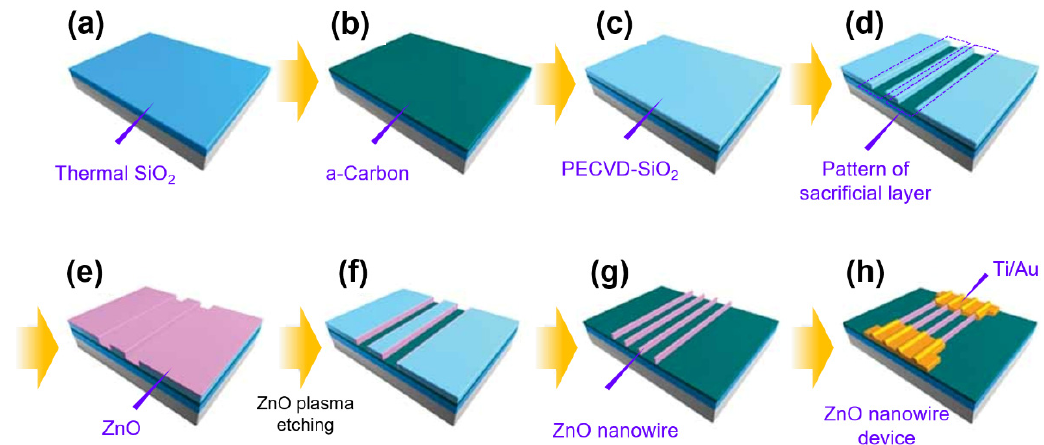
Figure 9. Schematic diagram illustrating the fabrication processes of the ZnO nanowire device based on nanoscale spacer lithography: ( a ) thermal SiO 2 deposition; ( b ) a-carbon deposition (etch-stop layer); ( c ) Plasma-enhanced chemical vapor deposition (PECVD) of SiO 2 (sacrificial layer); ( d ) sacrificial layer patterning; ( e ) ZnO atomic layer deposition (ALD); ( f ) top view after ZnO plasma etching; ( g ) sacrificial layer removal; and ( h ) ZnO nanowire device after metal electrode deposition. Reprinted from reference [194] with permission from the Copyright 2008 Wiley .